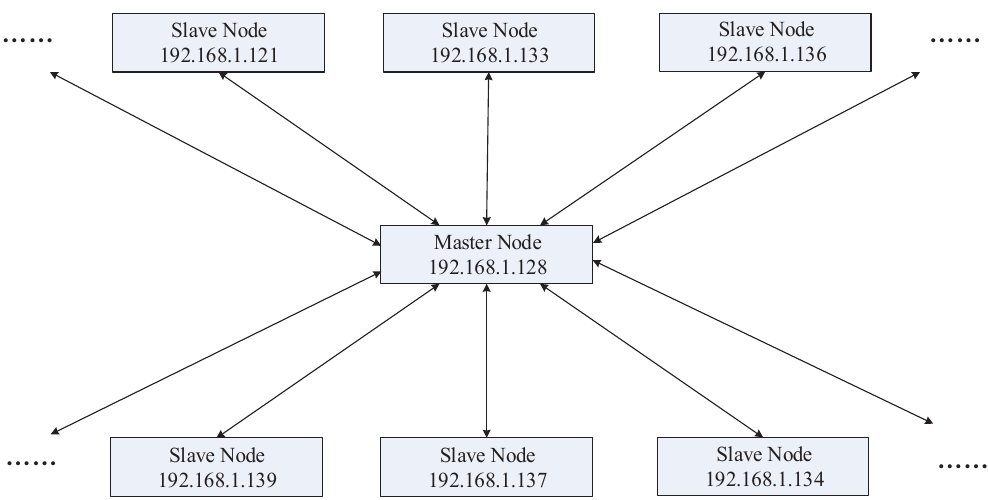
Figure 4. System configuration